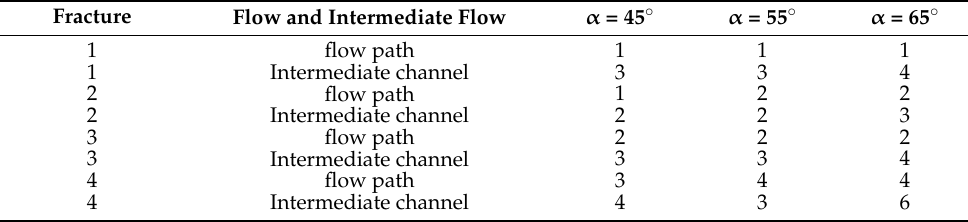
Table 2. The mean number of flow paths and intermediate channels for different fractures and in ‐ clinations.